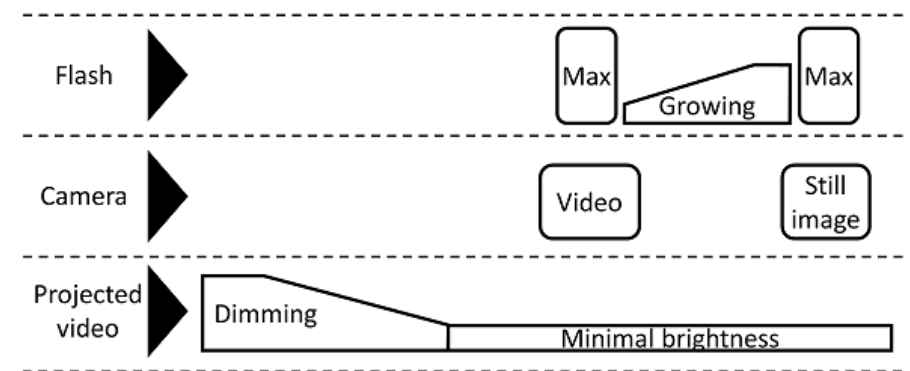
Figure 7. The exam timeline, from an illumination and image acquisition perspective. Max: maximum intensity.